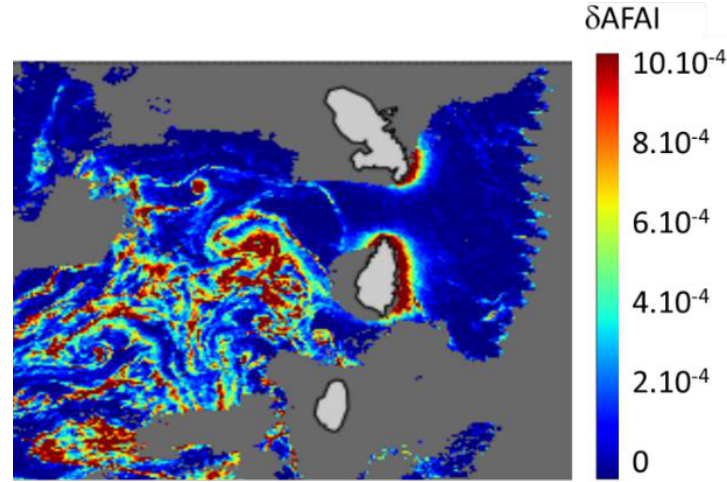
Figure 4. Alternative Floating Algae Index (AFAI) deviation ( δ AFAI) estimated from Terra-MODIS on 8 August 2018 at 14:35 UTC (ca. 10:30 local solar time).